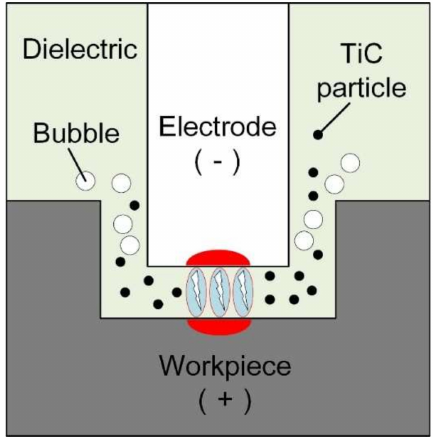
Figure 1. Principle of powder mixed EDM.